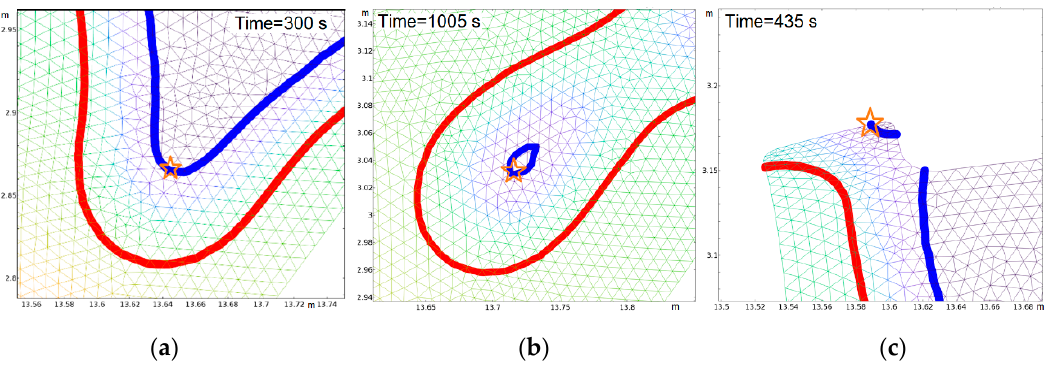
Figure 20. Determination of the filling start instants for all nodes. Three examples ( a – c ) of the filling start instants are present for the different nodes denoted by stars.